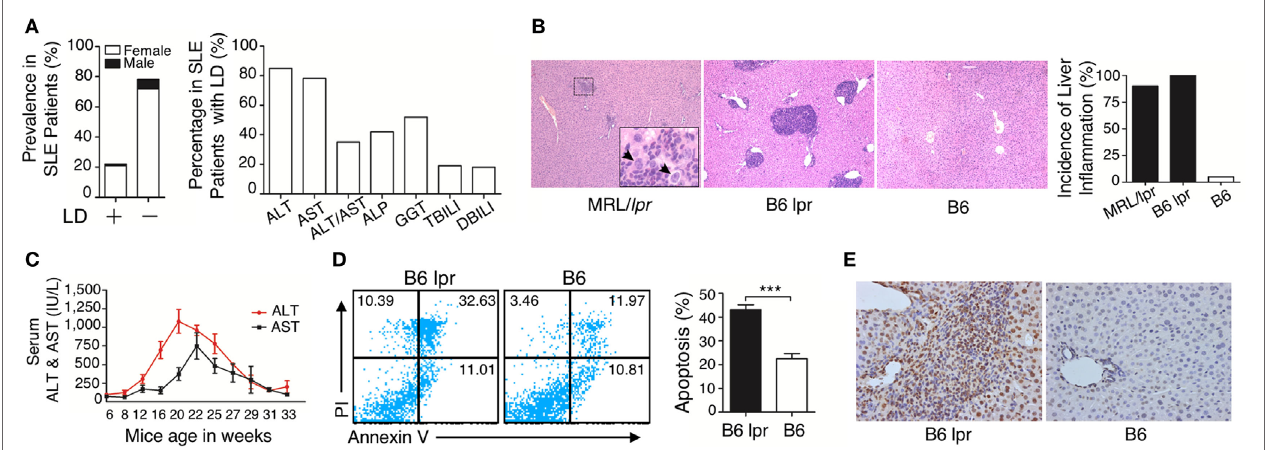
FigUre 1 | Characterization of liver damage in lupus disease. (a) Clinical information in the cohort of 404 systemic lupus erythematosus (SLE) inpatients was reviewed and liver dysfunction (LD) was detected in 91 out of 404 SLE inpatients, while the other 313 SLE inpatients without LD served as the control group (normal liver function group). Serum biochemical markers of LD in 91 SLE patients are shown. (B) Histopathological examination of the liver and incidence of hepatic inflammation from lupus-prone mice MRL/ lpr ( n = 7, 22 weeks), B6 lpr ( n = 10, 30 weeks), and B6 mice ( n = 10, 30 weeks). Infiltration of inflammatory cells around the portal vein in these two mice models with different genetic backgrounds. The arrow indicates ballooning degeneration of hepatocytes that was observed in ~5% of the portal area. Original magnification, 100 × . (c) Serum levels of liver enzymes in B6.MRL/lpr (B6 lpr) mice at various ages. ALT, alanine aminotransferase; AST, aspartate aminotransferase ( n = 10). (D) Analysis of apoptosis of liver cells from B6 lpr mice (30 weeks) and age-matched control B6 mice. *** P < 0.001 (the result is representative of three independent experiments, n = 4 mice per group/experiment.) (e) Representative photomicrographs of the TUNEL in situ assay of liver sections of B6 lpr mice (30 weeks) with hematoxylin as a counter-stain. Original magnification, 400 ×